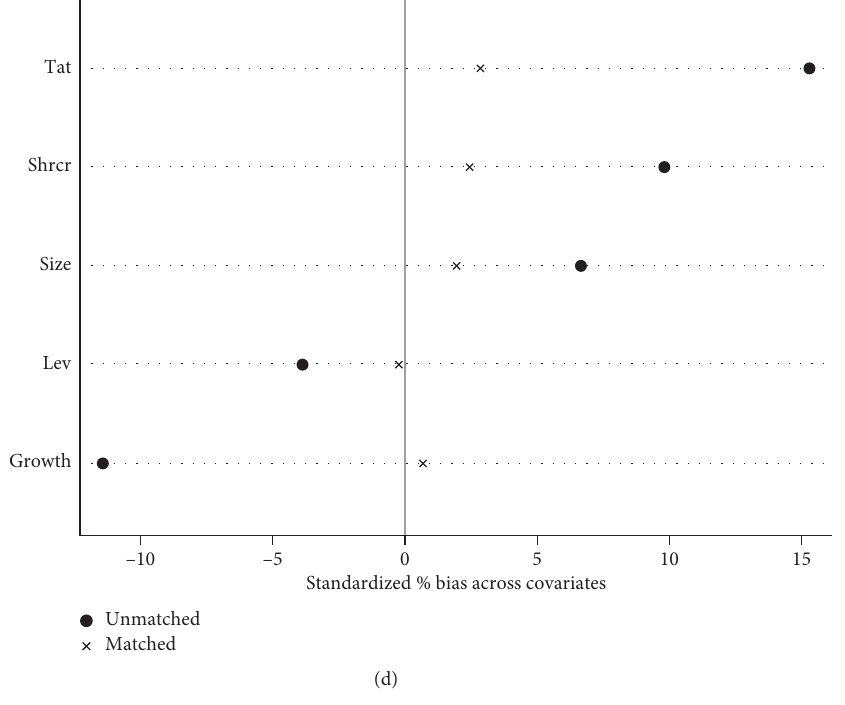
Figure 1: Common support hypothesis testing.